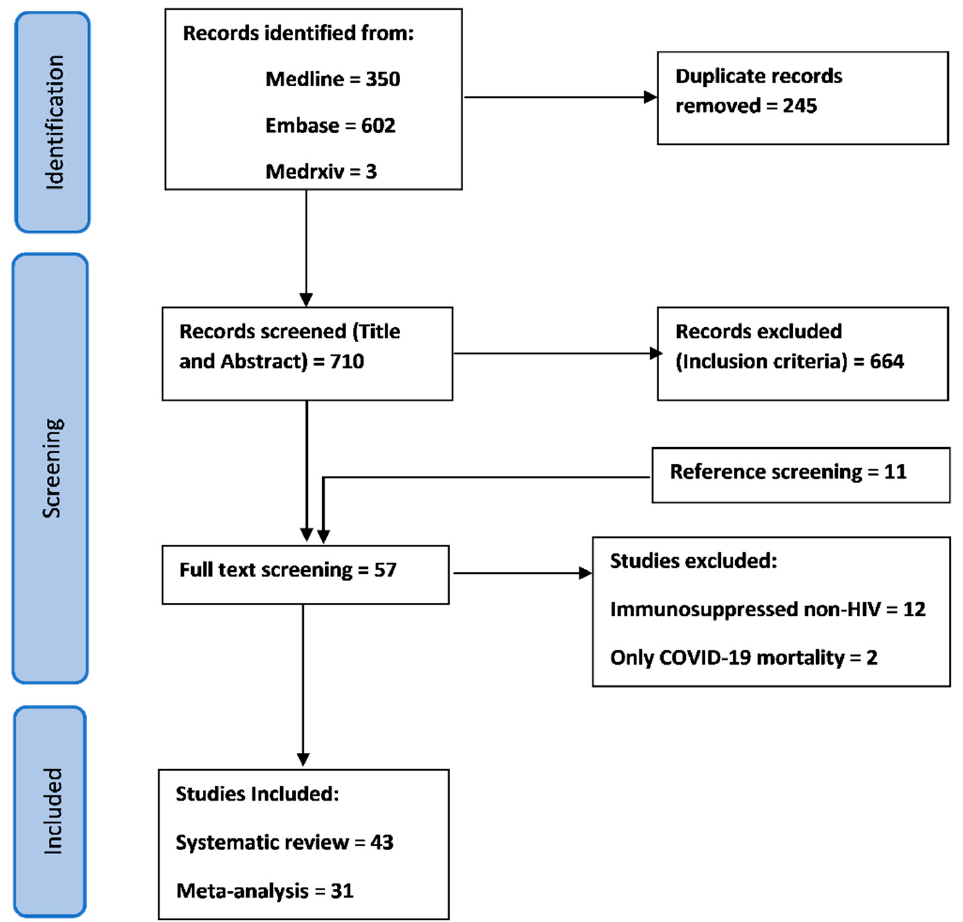
Figure 1. Global and regional prevalence and outcomes of COVID-19 in people living with HIV: A systematic review and meta-analysis according to the Preferred Reporting for Systematic Reviews and Meta-analyses diagram.